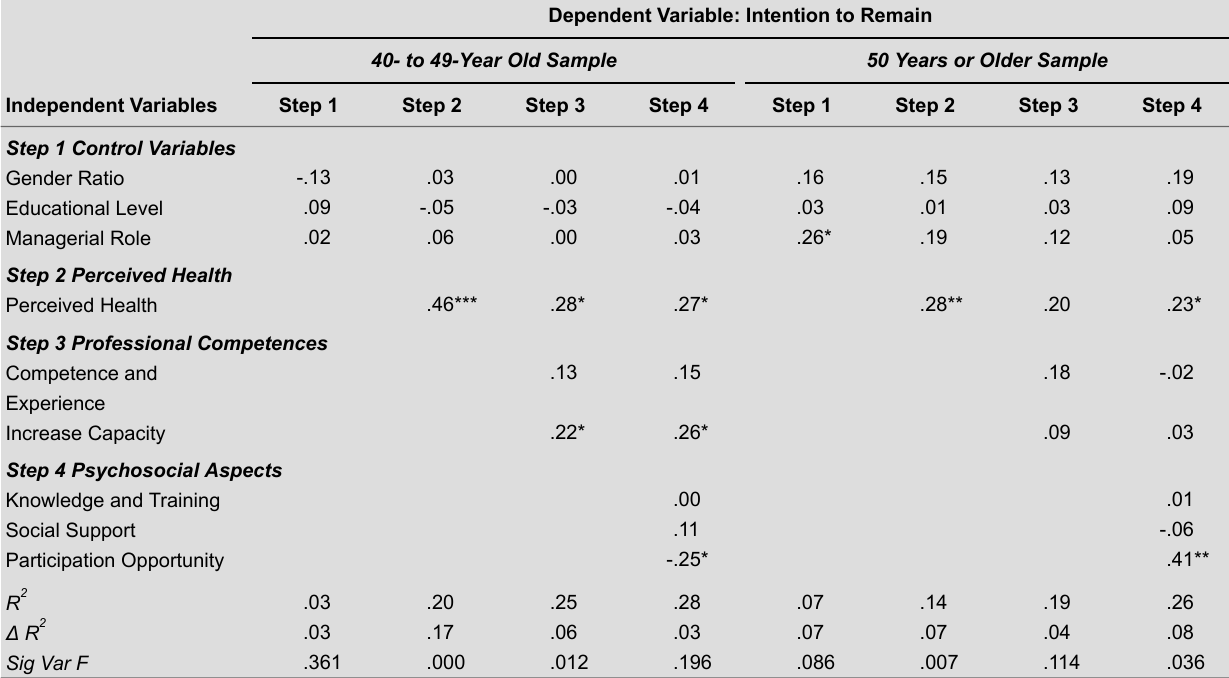
Results of Hierarchical Regressions: Intention to Remain on Health, Professional Competences and Psychosocial Aspects Among Age Dependent Variable: Intention to